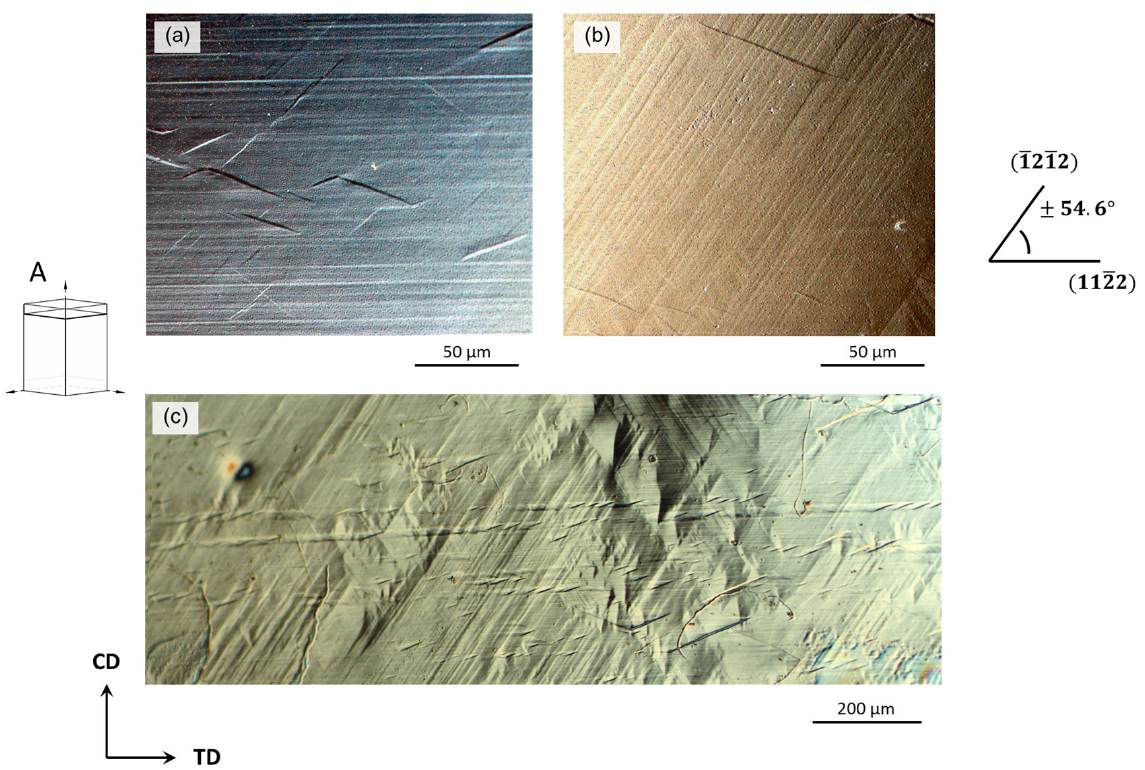
Figure 6. Optical micrographs (C-DIC) of a prepolished CD-LD side of a specimen with the initial orientation A showing ( a ) horizontal slip traces, ( b ) fine diagonal slip traces and ( c ) rutted surface with a diamond ‐ like slip pa tt ern.